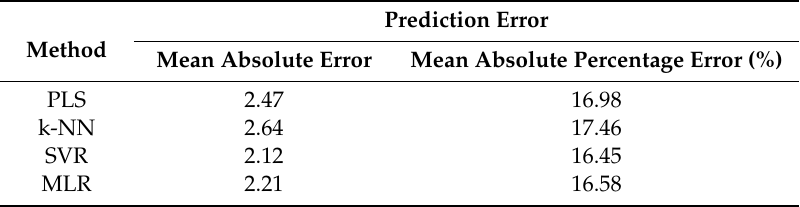
Table 5. Comparison of model performance in terms of vehicle price estimation.